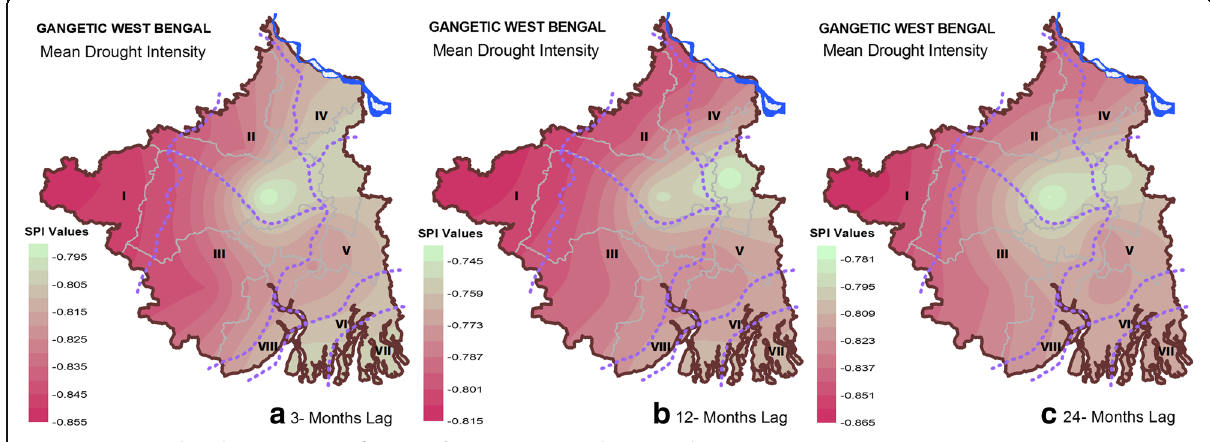
Fig. 4 Iso-average drought intensity map for ( a ) 3-, ( b ) 12-, ( c ) 24- months time scale